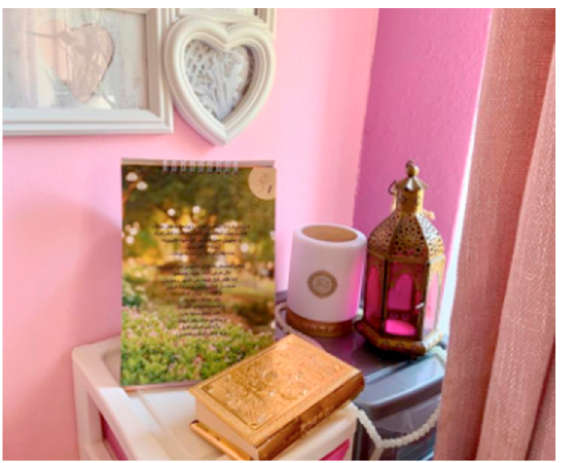
Figure 3. Sumayya’s bedroom Ramadan corner (Sumayya, Diary Image, Entry 1).